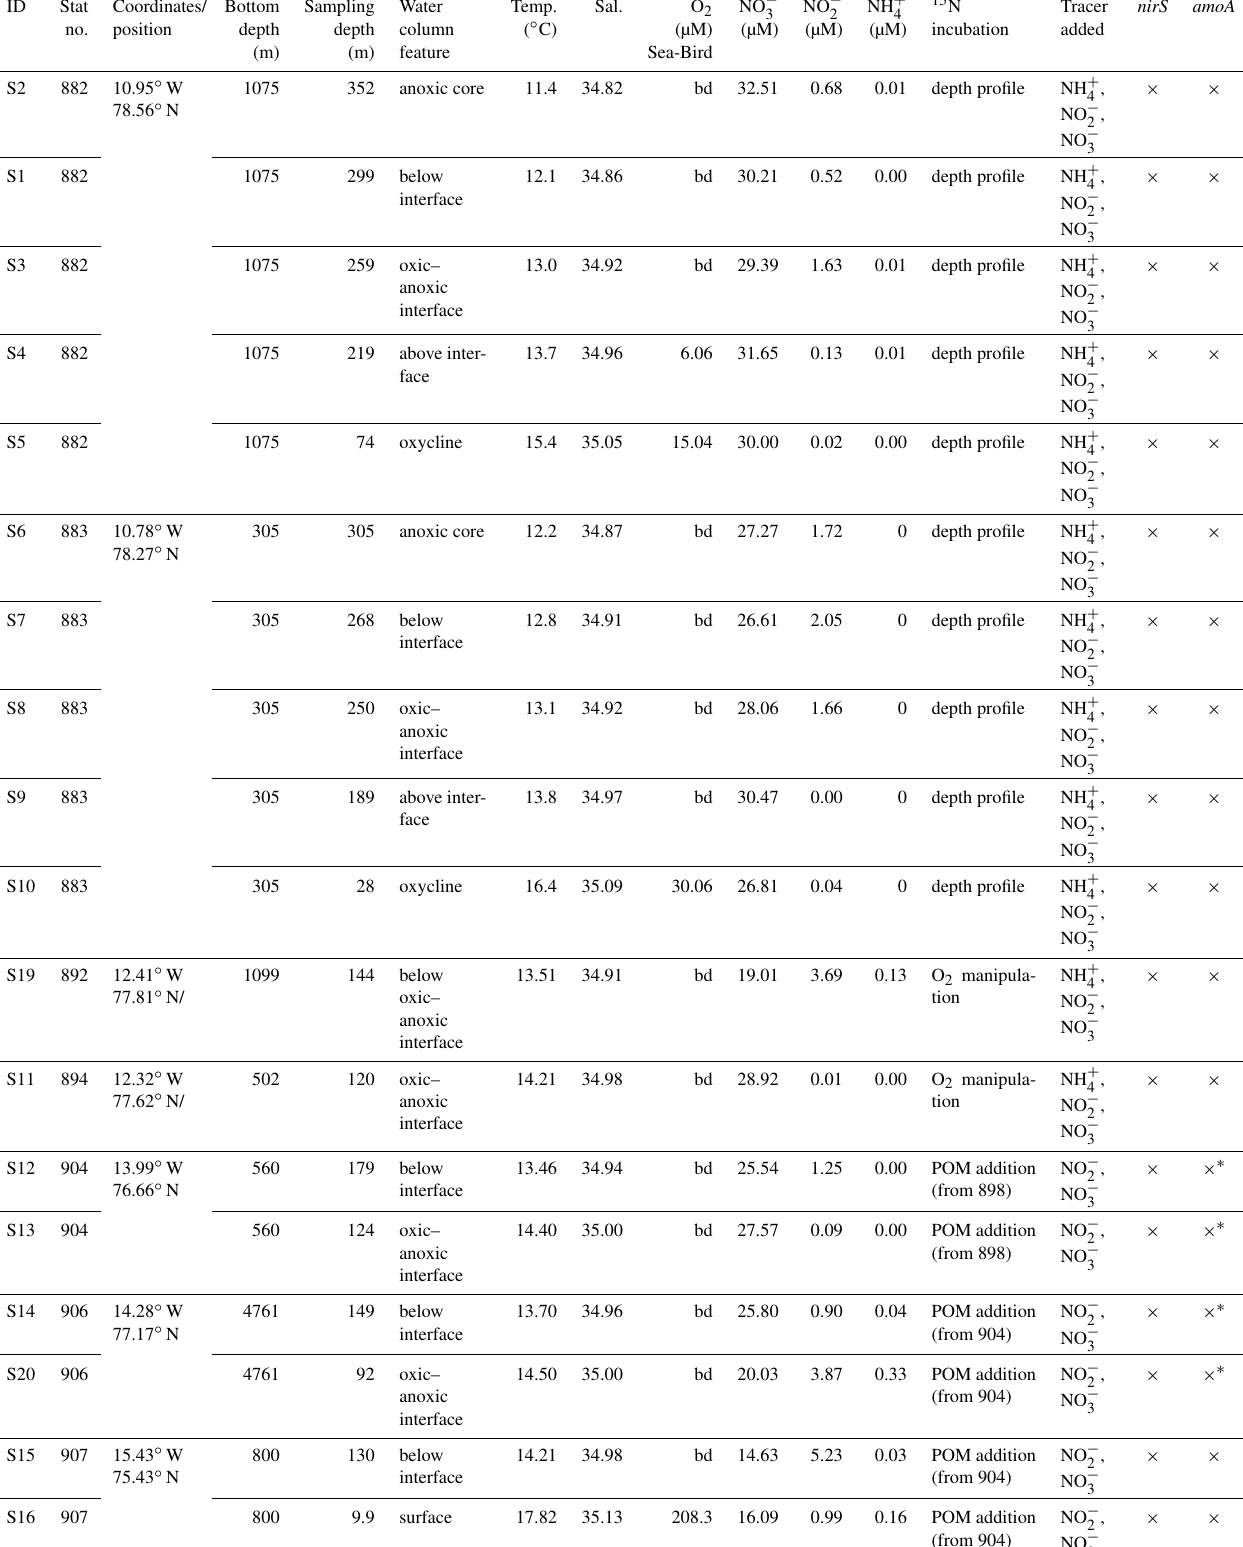
Table 1. Overview of characteristics of samples. bd – below detection limit of the Winkler method and Sea-Bird sensor (2µmolL − 1 ); × – analysis includes qPCR and microarray with qPCR products; × ∗ – only qPCR, no microarray. ID Stat Coordinates/ Bottom Sampling Water